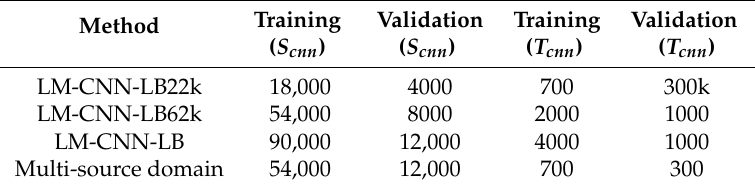
Table 4. Composition of different size